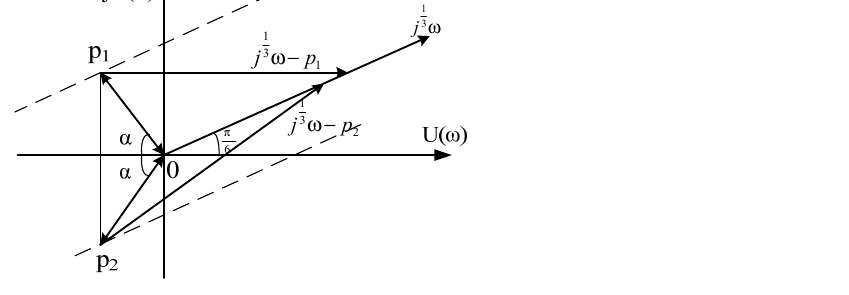
Figure 15. Vector displacement for the first two complex-conjugate roots for the case when 𝜔 𝜖 (0, ∞) .